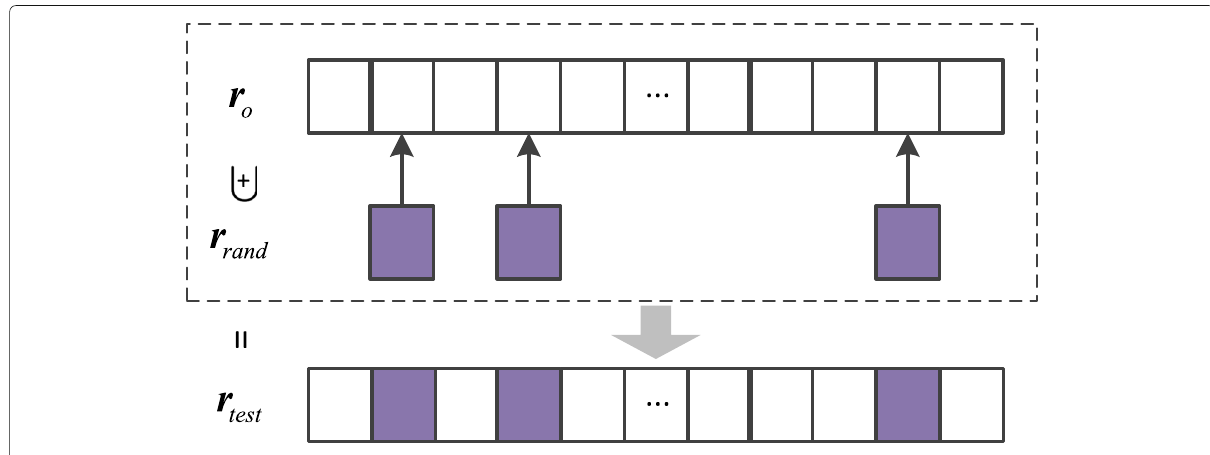
opposite. The attacker tries to counterfeit positive resid- uals, making the real value of the target process variable decrease over time until the system crashes. In this sce- nario, the skewness coefficient of the observed residuals is negative, since the residual distribution is left-skewed as illustrated in Fig.